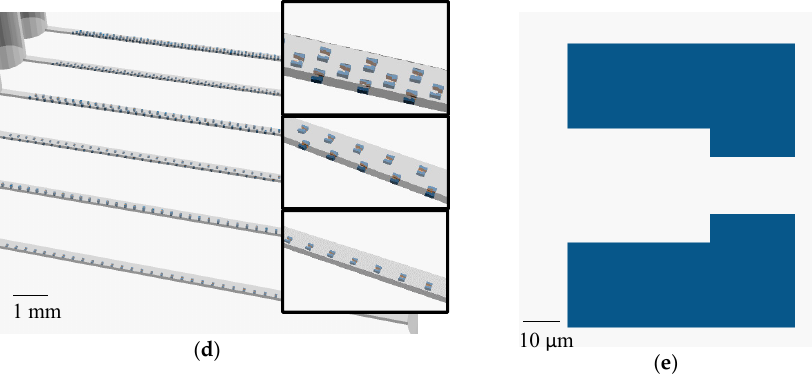
Figure 1. OpenSCAD designs of prints for exterior and interior resolution features. ( a ) Ridge device. The ridges are shown in red and there is a support box around the ridges. The ridges are 100 μ m tall and have widths of 1–10 pixels (7.6–76 μ m) from left to right. The cutout shows a zoom view; ( b ) Trench device with the trenches shown in orange. The trenches are 100 μ m deep and have widths of 1–10 pixels (7.6–76 μ m) from left to right. The cutout shows a zoom view; ( c ) Interior features device. The top layers of the device have been removed in the schematic to show the features. From left to right the regions are ridges, trenches with exposure compensation, pillars, and trenches without exposure compensation. Each set of features has a series of ceiling support ridges running the length of the feature area. Below each feature void area is a zoom view; ( d ) Bead trap device design showing 6 channels and traps within channels. Inserts show a zoom view of the three different trap layouts; ( e ) Schematic of bead trap. The large gap is designed to allow the beads to enter and the smaller gap allows fluid to pass through the trap.